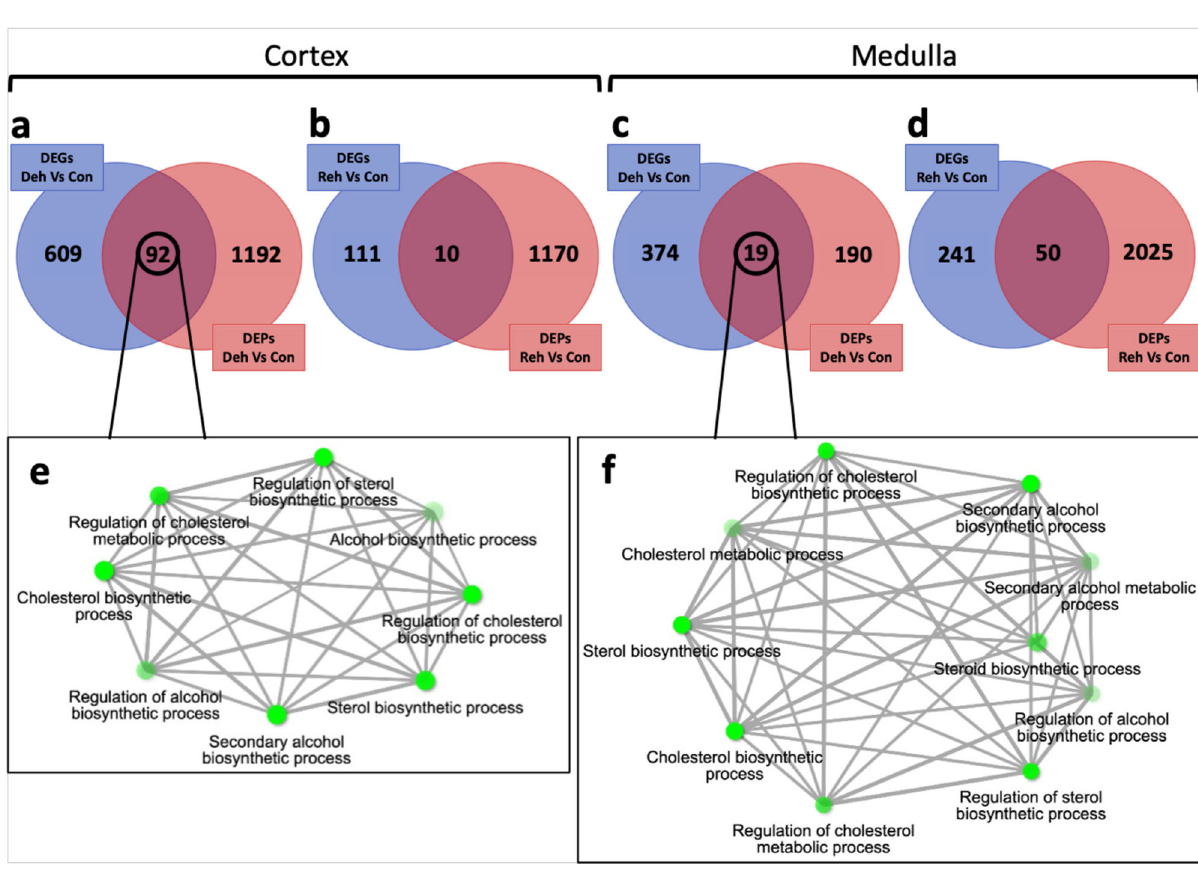
Fig. 4 Tissue and treatment-speci fi c comparison between matched DEGs and DEPs. a – d Venn plots showing the overlap (dark red) of differentially expressed genes (DEGs) for which their corresponding differentially expressed proteins (DEPs) were also identi fi ed in the ( a ) cortex during dehydration, ( b ) cortex during rehydration, ( c ) medulla during dehydration and ( d ) medulla during rehydration. The Venn plots also display the number of genes (blue) and proteins (light red) differentially expressed at either RNA or protein level only. e , f Gene Ontology (GO) networks displaying a subset of the most signi fi cantly enriched ( p < 0.05) biological processes in the kidney cortex ( e ) and medulla ( f ) during dehydration. Two nodes are connected if they share 20% or more genes and thicker edges represent more overlapped genes, darker nodes are more signi fi cantly enriched gene sets and bigger nodes represent larger gene